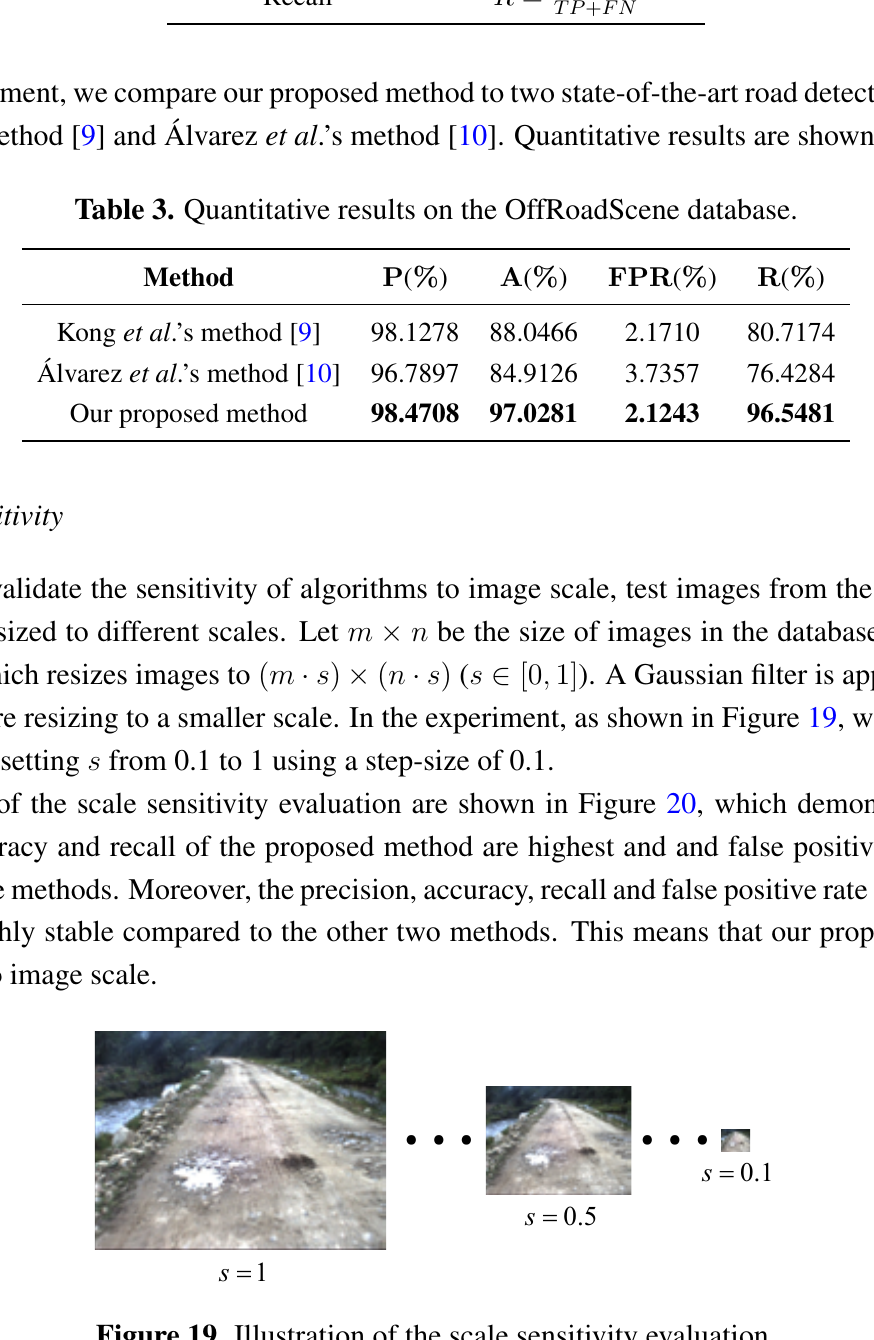
Figure 19. Illustration of the scale sensitivity